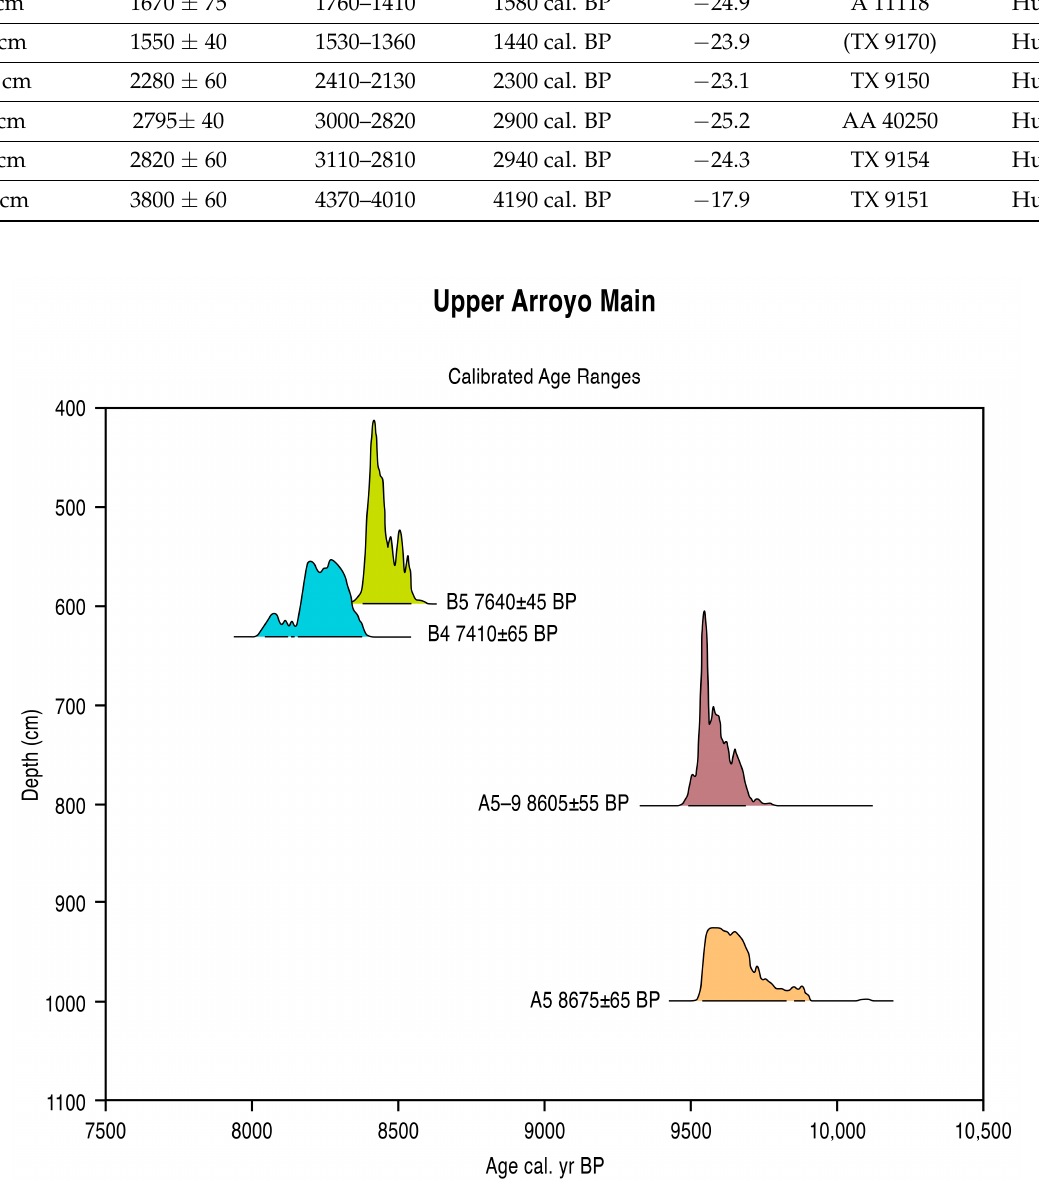
Figure 6. Age–depth graph with the 2-Sigma plot for Upper Arroyo main sequence, lower part.